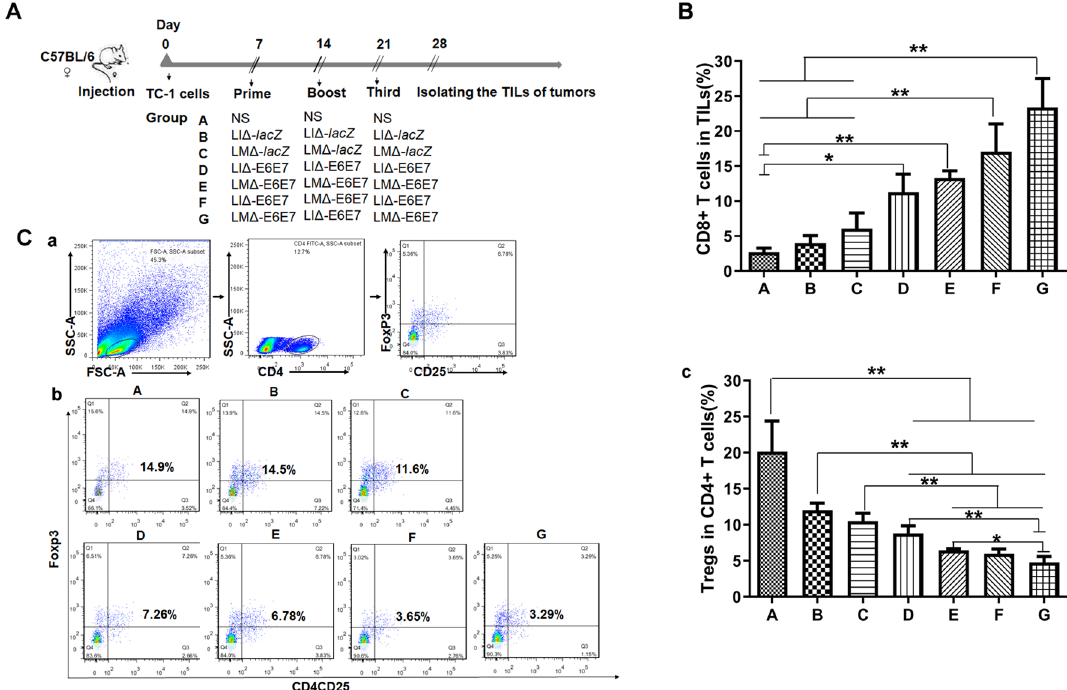
Figure 6. The percentage of Tregs and CD8 + T cells in TILs after immunotherapy. As ( A ) showed, TILs were isolated from tumors of mice in different groups (5 mice/group) at 7 days after the final vaccination. ( B ) Comparison of the percentage of CD3 + CD8 + T cells in tumors of each group. ( C ) The percentage of Tregs in tumors. (a) Flow gate strategy. (b) Flow cytometry analysis of the frequency of CD4 + CD25 + Foxp3 + Tregs in tumors from mice of each group. (c) Comparison of the percentage of CD4 + CD25 + Foxp3 + Tregs of each group. Data in this figure are representative of three independent experiments. * P < 0.05, ** P <